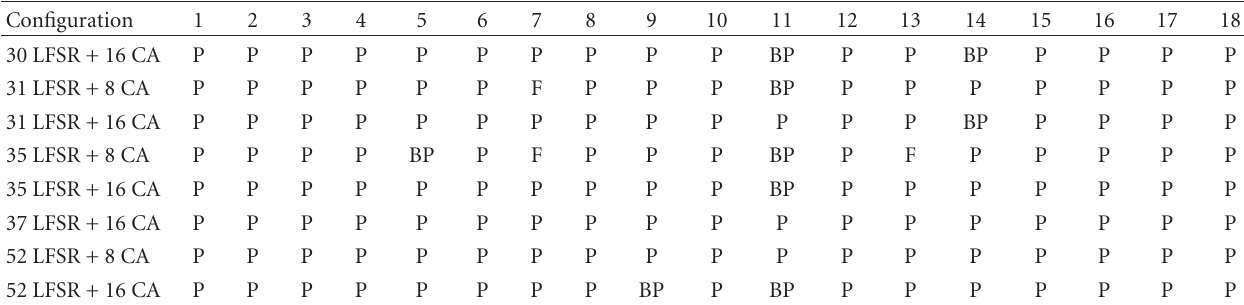
Table 3: Diehard results for LFSR + CA maximum site spacing.